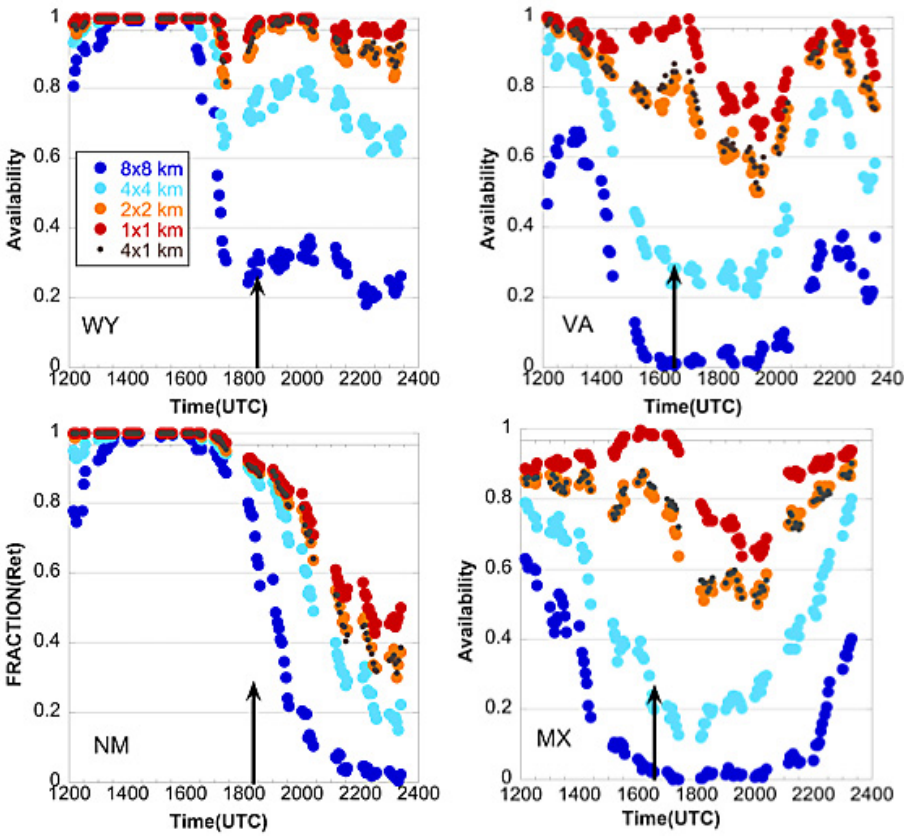
Fig. 11. Diurnal patterns of aerosol retrieval availability on 12 August 2010 for four different spatial resolutions for the four 1-degree local areas defined in Fig. 9. The availability was calculated using the GOES-R cloud mask applied to one day of GOES radiances archived at 5-min temporal resolution. Black arrows point to times of Terra overpass. The 4 × 1km is denoted by small brown circles that are almost exactly overlaid onto the 2 × 2km orange